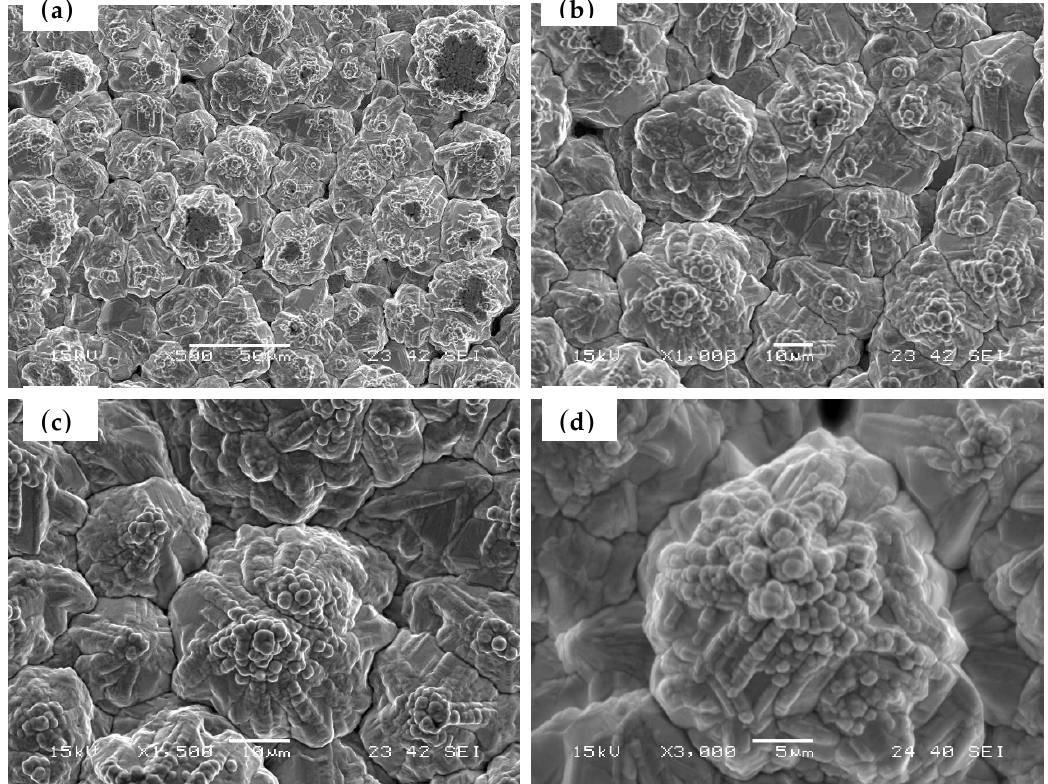
× 500 ( b ) × 1000 ( c ) × 1500 ( d ) ×